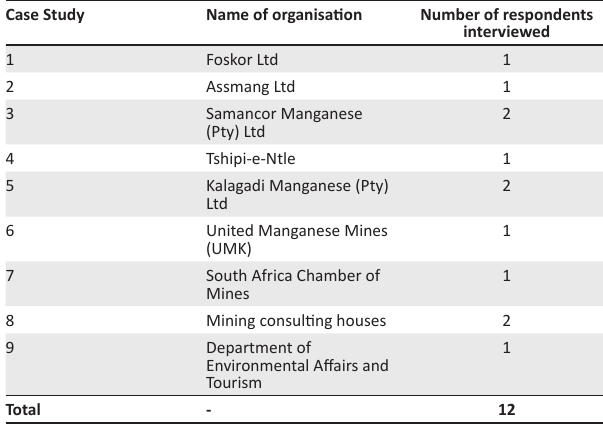
TABLE 1: Organisations from which the respondents were